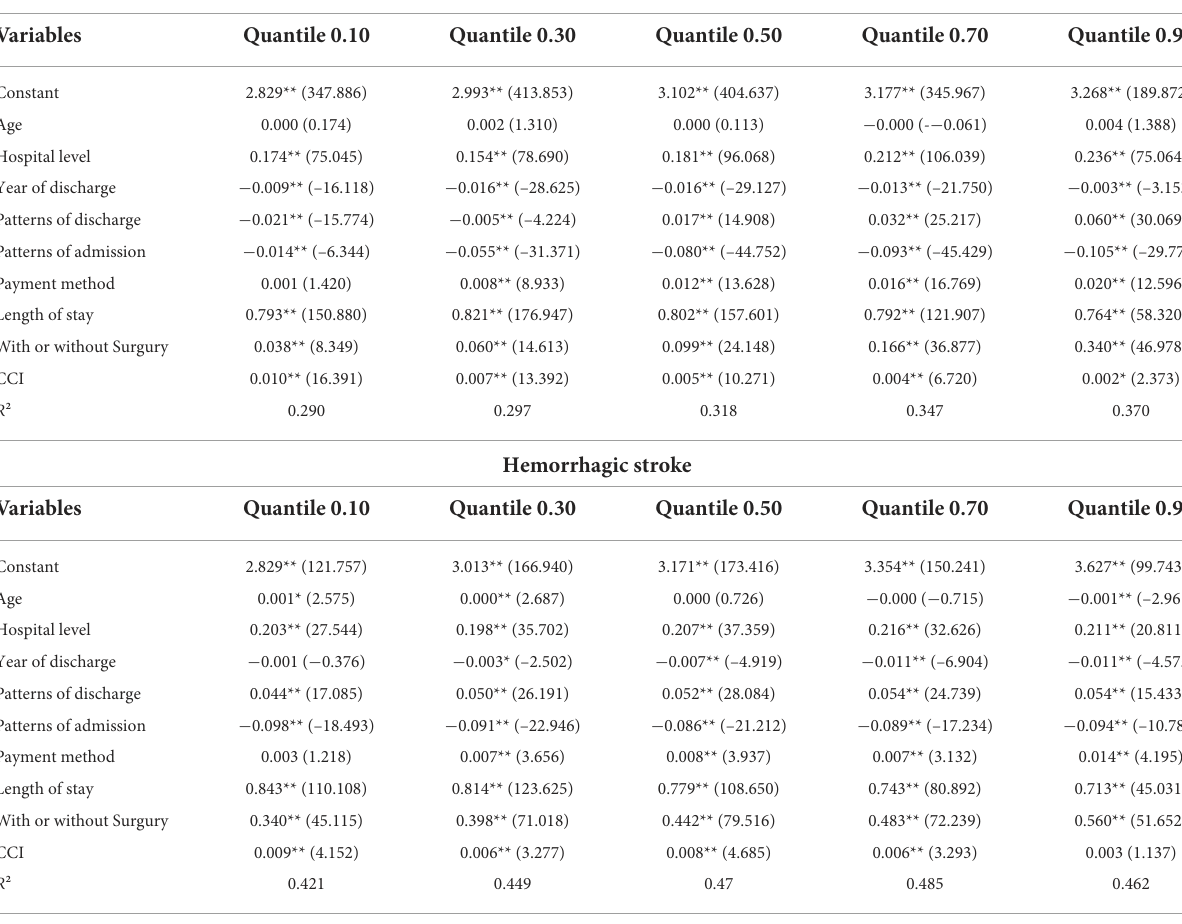
TABLE 2 Association between the factors and the hospitalization costs of inpatients with the in the quantile regression